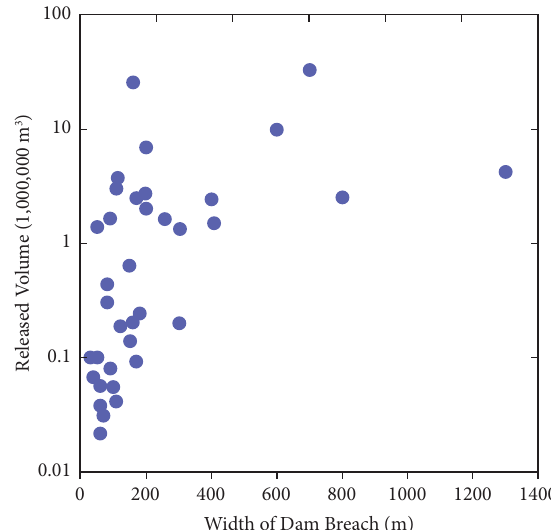
Figure 17: Released volume as a function of width of dam breach (data from Rana et al.